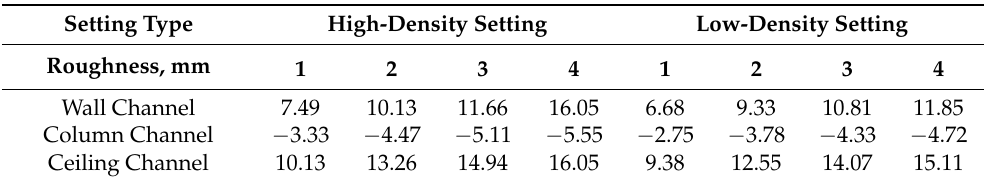
Table 4. Percentage reductions in average velocities in different channels in the kiln for different kiln boundary surface roughness levels.